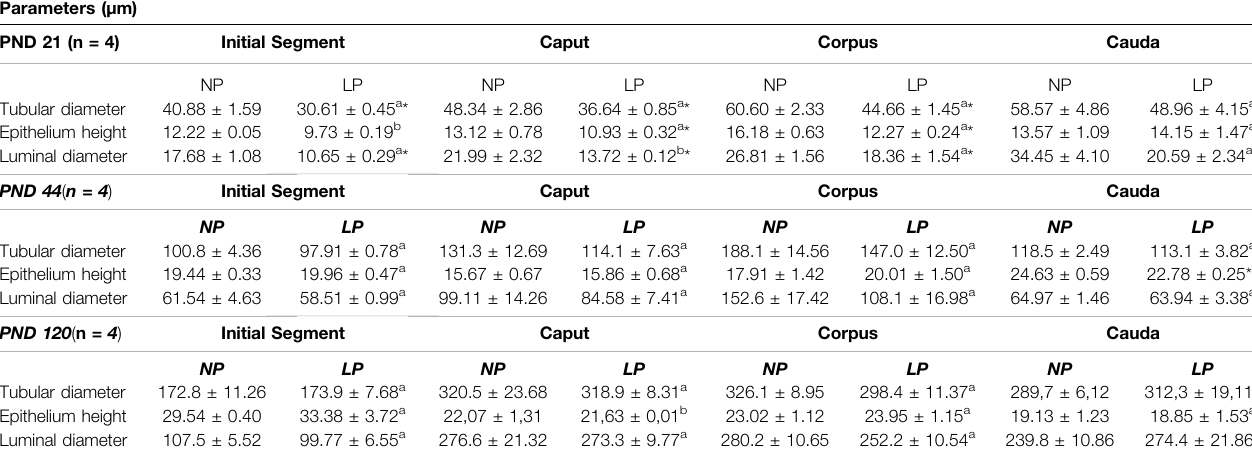
TABLE 4 | – Morphometry of the epididymis. Tubular diameter, epithelium height and luminal diameter at PND 21, 44 and 120. NP, n = 4; LP, n = 4. Values expressed as means ± S.E.M. * p < 0.05. Student t-teste was used for parametric data (a), and Mann-whitney test was used for non-parametric data (b). Parameters